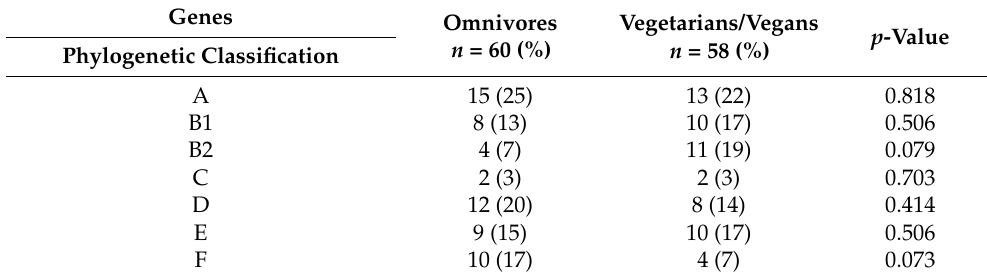
Table 8. Phylogenetic classification among E. coli isolated from omnivores and vegetarians/vegans.